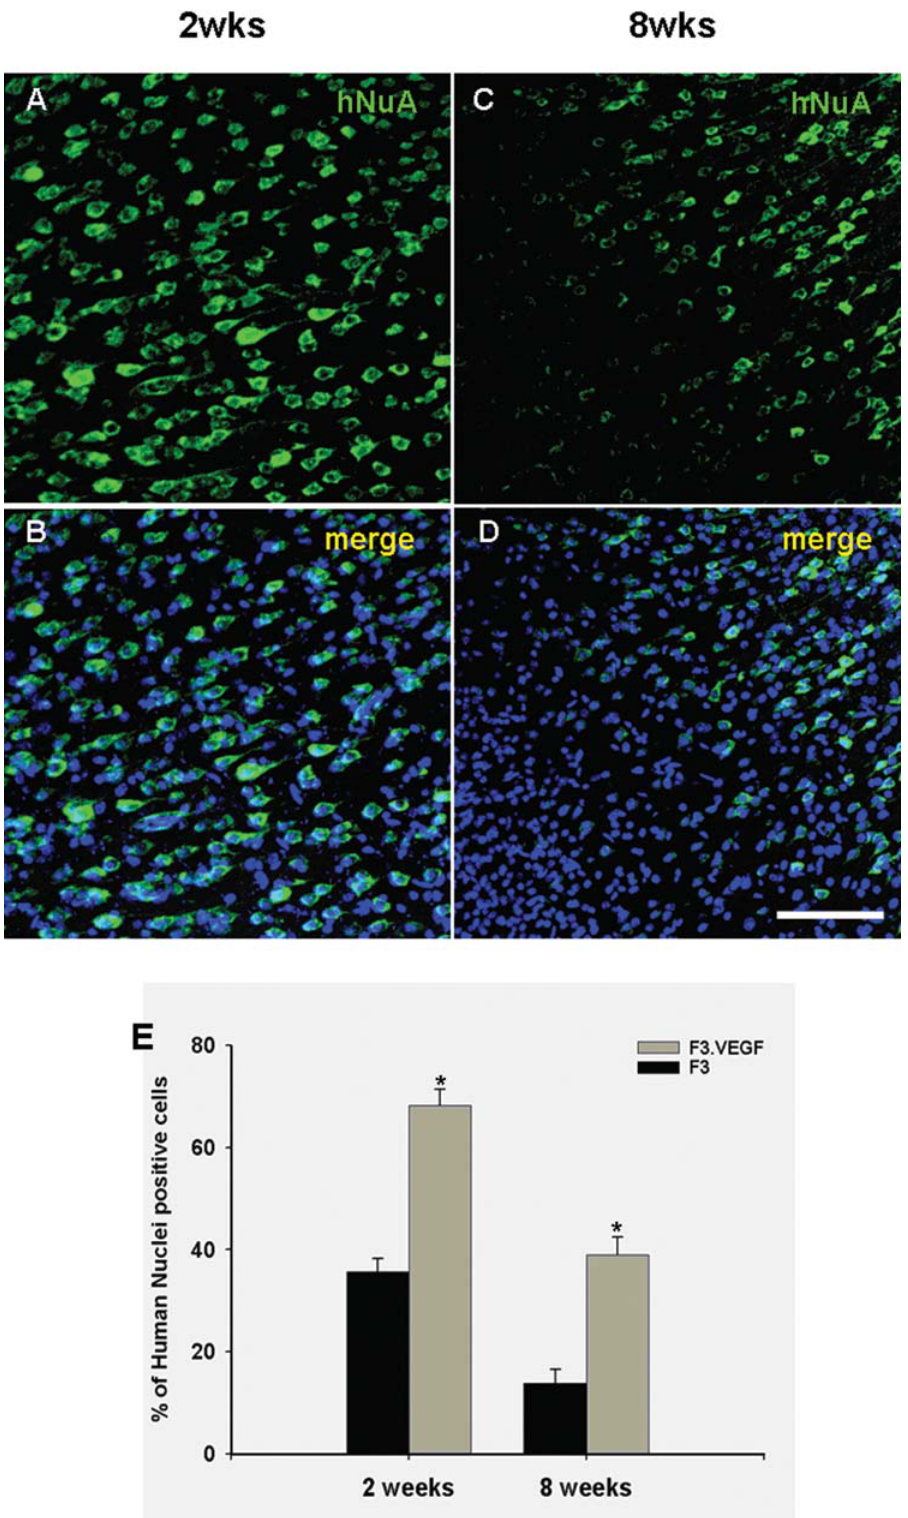
Figure 5. Survival of grafted F3.VEGF human NSCs was demonstrated by immunofluorescence microscopy of human nuclear matrix antigen (HuNuA)/ DAPI (A/C-2 weeks, B/D-8 weeks post-transplantation). Number of surviving human NSCs expressing HuNuA (means 6 SE) in ICH mouse brain at 2 and 8 weeks post-transplantation (E). * P , 0.001